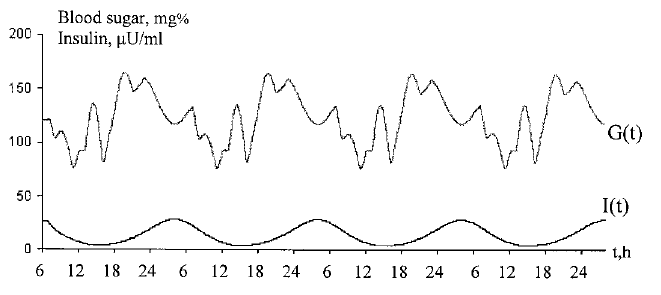
(cid:12)timesbeforeameal(cid:8)